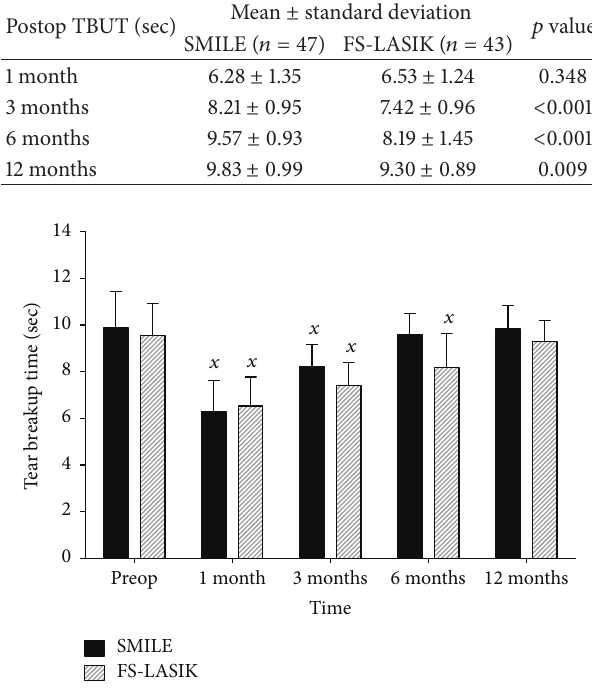
Figure 1: Tear-film breakup time (TBUT) in SMILE and FS-LASIK groups before operation, 1, 3, 6, and 12 months after operation. “ 𝑥 ”: statistically significantly less than preoperative values, 𝑝 < 0.05